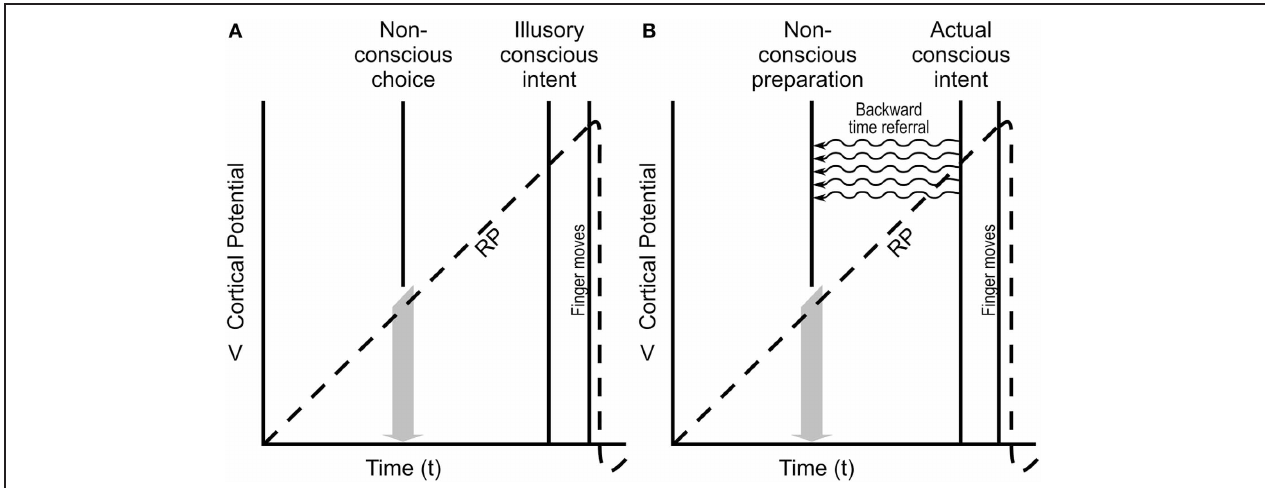
FIGURE 6 | The “readiness potential (RP)” (Libet et al., 1983). (A) Cortical potentials recorded from a subject instructed to move his/her hand whenever he/she feels ready, and to note when the decision was made (Conscious intent), followed quickly by the finger actually moving. (Time between Conscious intent, and finger moving is fixed.) Readiness potential, RP, preceding Conscious intent is generally interpreted as